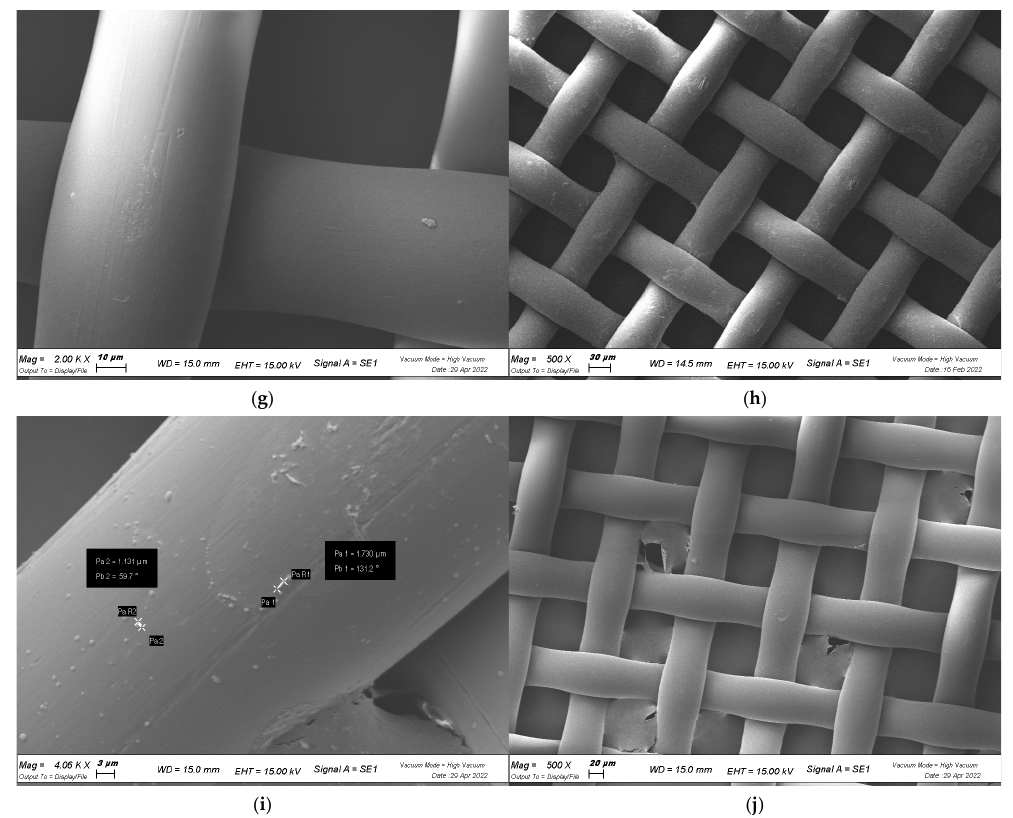
Figure 5. E ff ects of bio fi lm formation on abiotic surface by SEM visualization. ( a – d ) Control (CTRL) samples; ( e , f ) HA-MOL; ( g , h ) HAMD-MOL; ( i , j ) MeOH-MOL. Controls are shown at magni fi cation of 1.46 K, 4.4 K, 500, and 2 K×. Treated samples are shown at magni fi cation of 2 K and 500×, except for ( i ), which, in order to visualize bacterial size, is shown at magni fi cation of 4.06 K×.